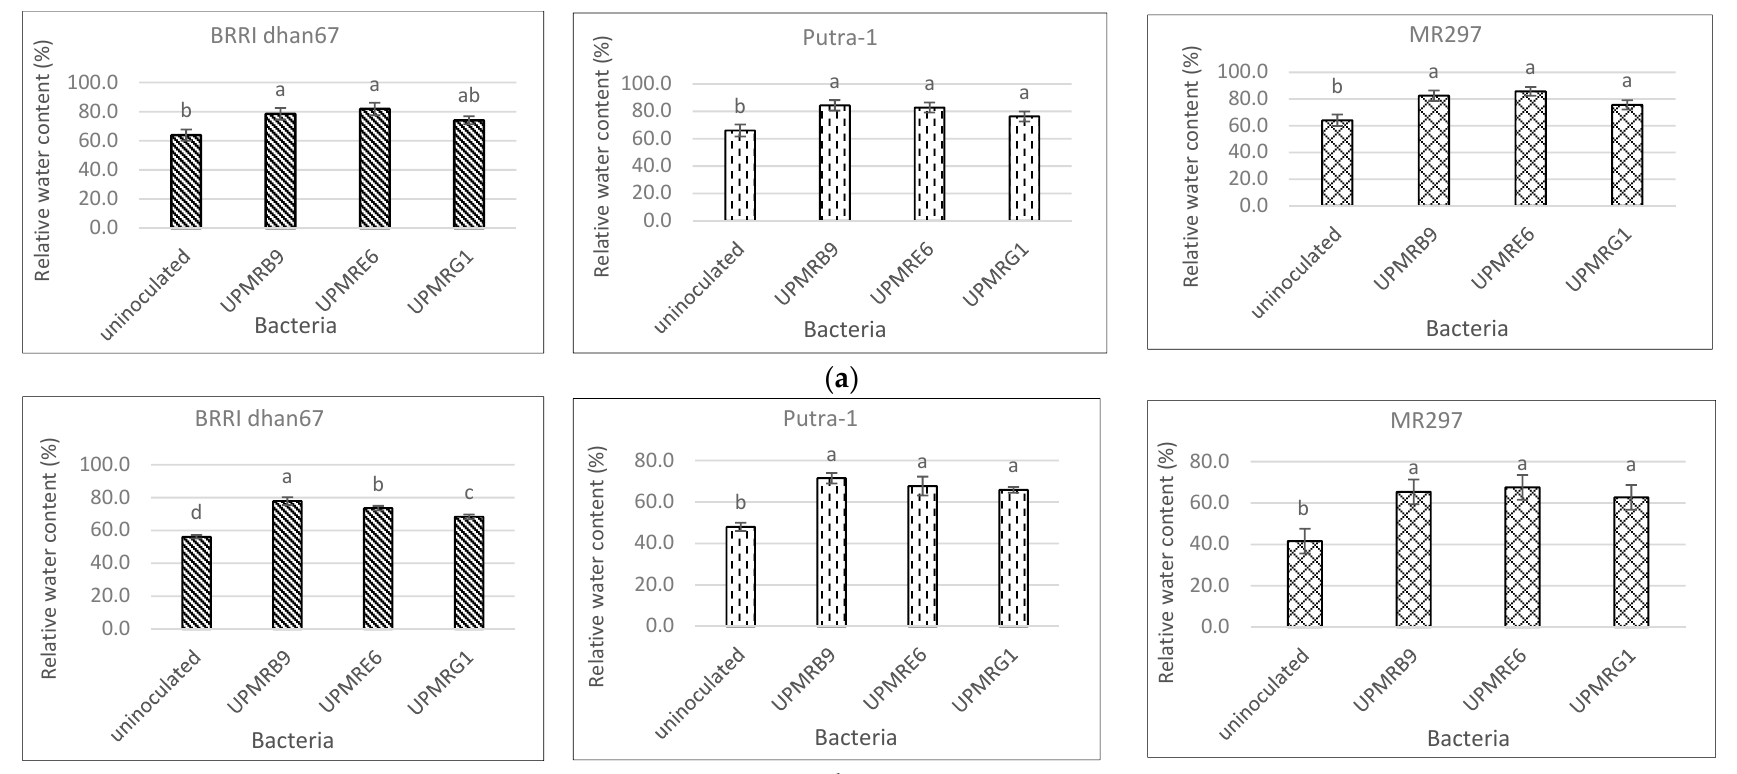
Figure 3. ( a ) Effect of bacterial inoculation on the relative water content of three rice varieties under non-saline conditions. Means with the same letter in a column do not differ significantly using Tukey’s test at p > 0.05. ( b ) Effect of bacterial inoculation on the relative water content of three rice varieties under saline conditions. Means with the same letter in a column do not differ significantly using Tukey’s test at p > 0.05.